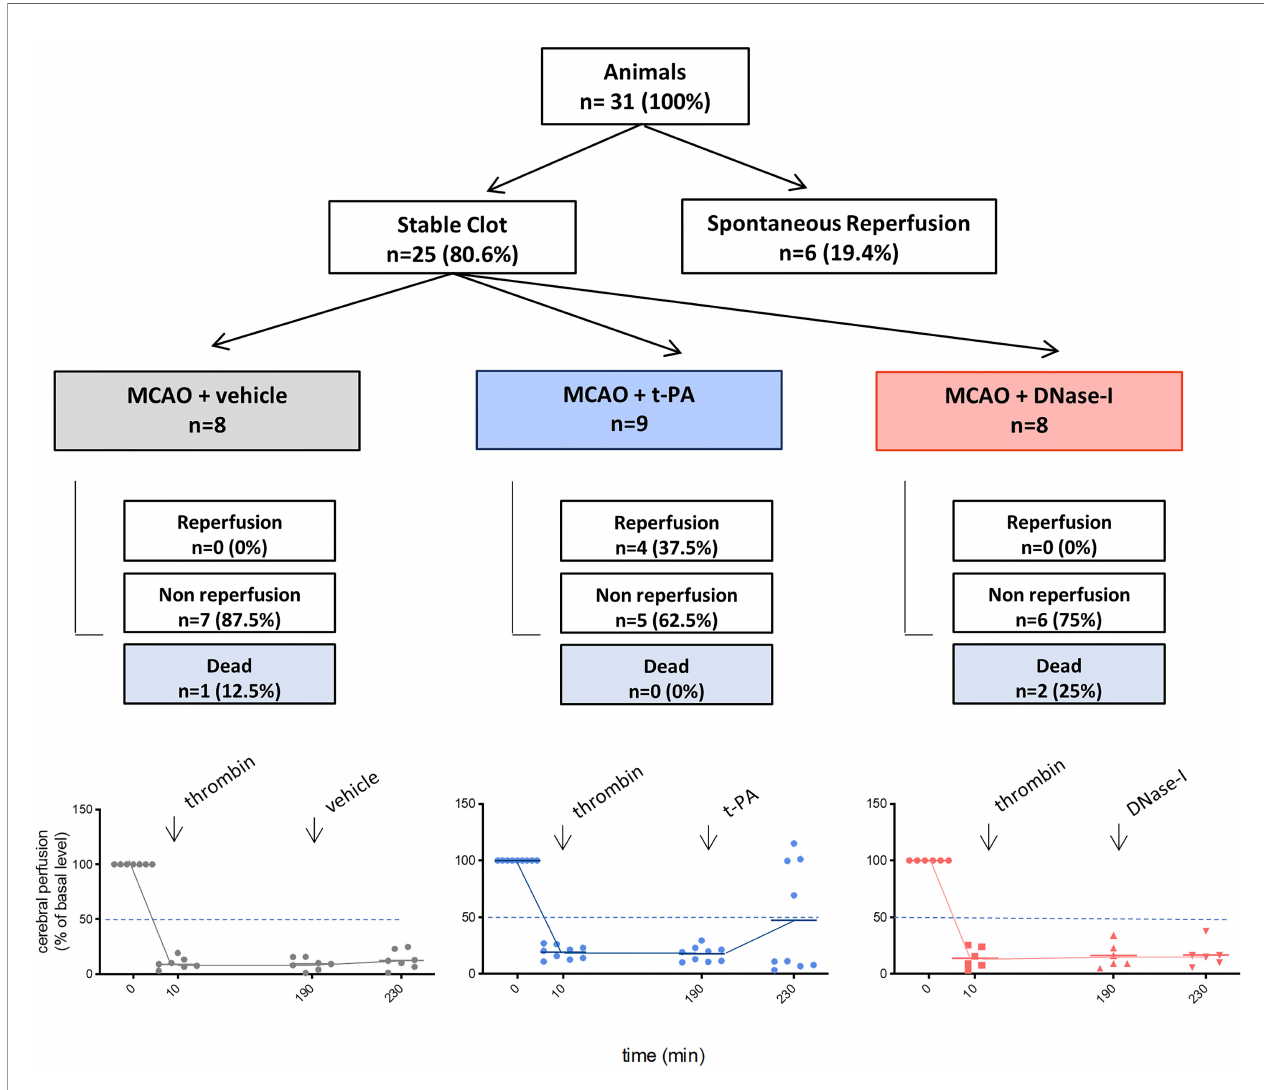
FIGURE 1 | Flow chartofthestudy. MCAO indicatesmiddlecerebralarteryocclusionbythe thromboembolic insitu strokemodel;